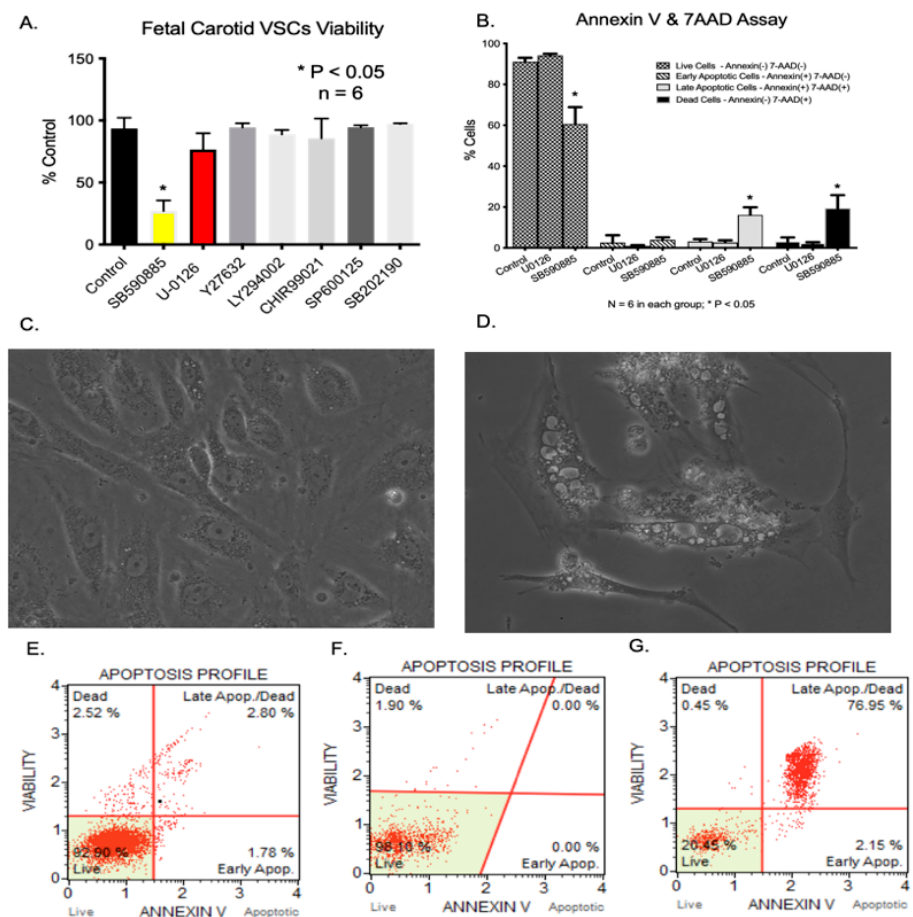
Figure 6. ( A ) Signi fi cant reduction in fetal VSCs viability following incubation with B-Raf inhibitor SB590885. There was no signi fi cant reduction in VSCs viability in response to other inhibitors. ( B ) Signi fi cant apoptosis following B-Raf inhibition. ( C ) Fetal VSCs in DMEM media. ( D ) Cells undergoing vacuolar cell death following incubation with B-Raf inhibitor SB590885 for 24 h. ( E – G ) Representative pictures of apoptosis assay following incubation with vehicle control, U1026, and SB590885. * Denotes p < 0.05, n = 5. Images shown in panels C and D were taken at 20× magni fi cation.